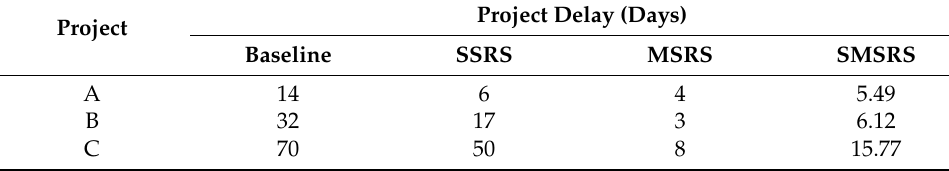
Table 9. Project delay summary.